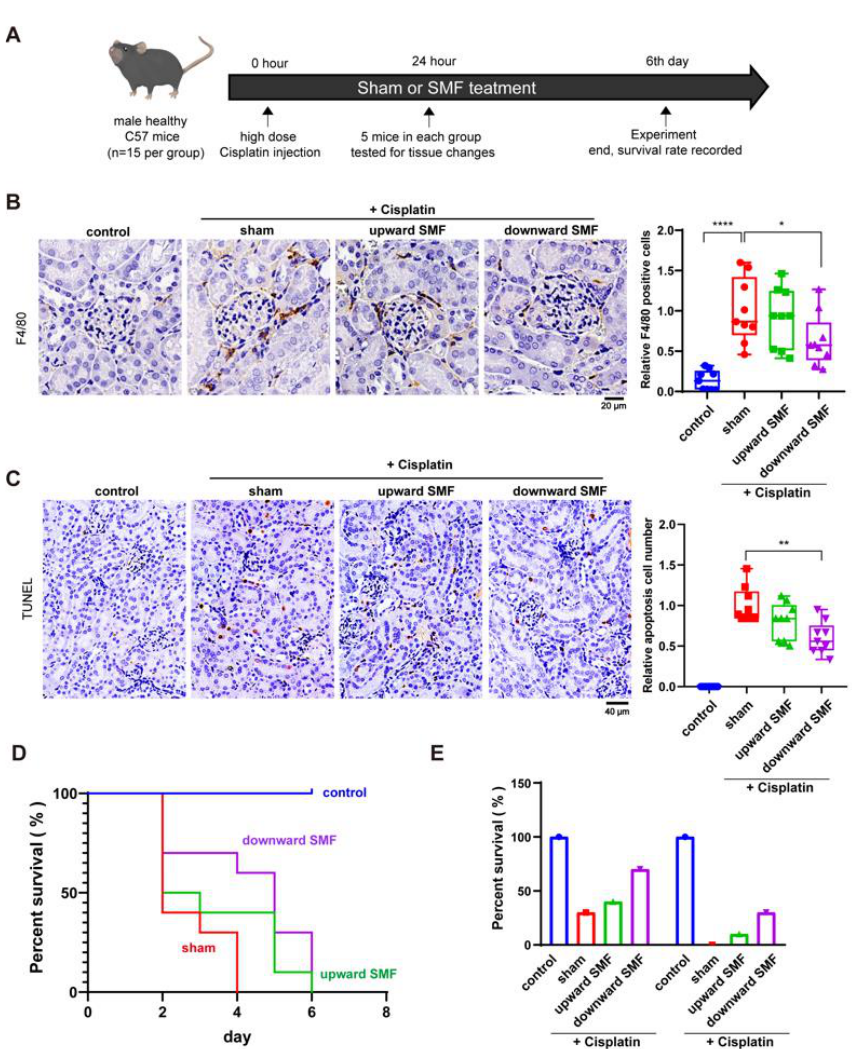
Figure 5. SMFs ameliorate high dose cisplatin-induced acute kidney injury. ( A ) Schematic diagram of high-dose cisplatin-induced acute kidney injury experimental procedures. ( B ) Representative images and quantifications of F4/80 staining. ( C ) Representative images and quantifications of TUNEL staining. ( D , E ) Percent survival for mice with or without high doses of cisplatin and/or SMF treatment. Values were expressed as means ± SD, * p < 0.05; ** p < 0.01, **** p < 0.0001.